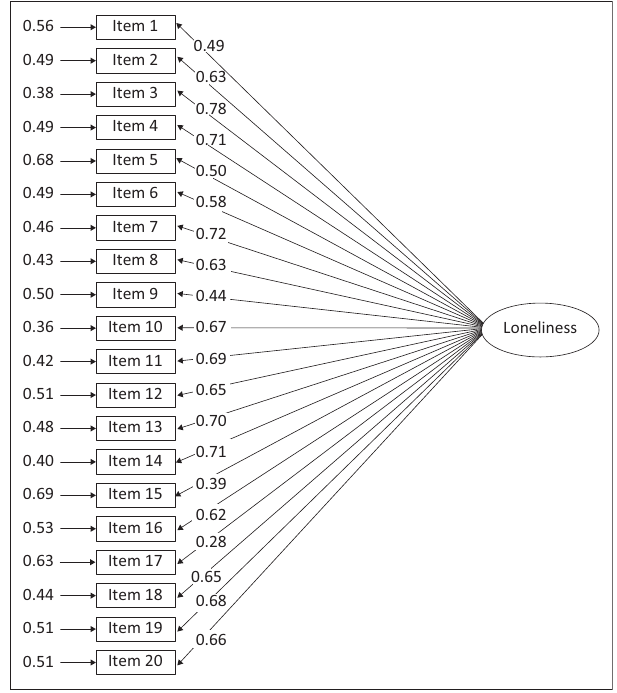
FIGURE 1: One-factor model of